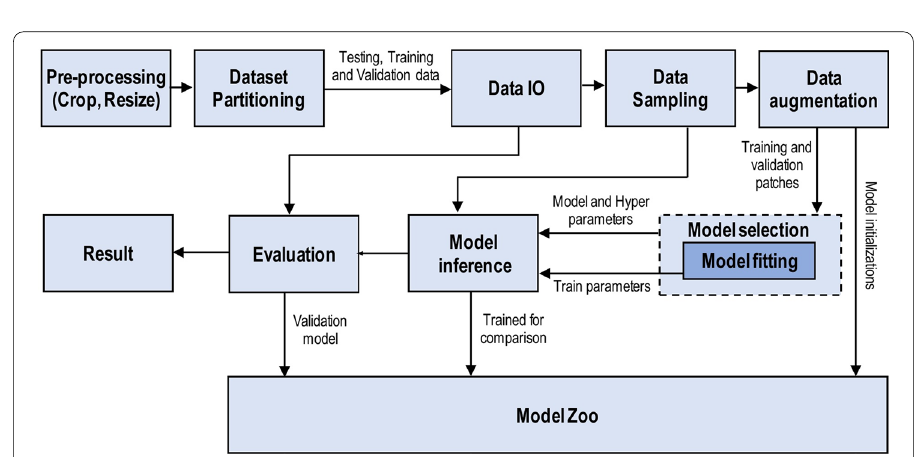
Fig. 30 Workflow of deep learning